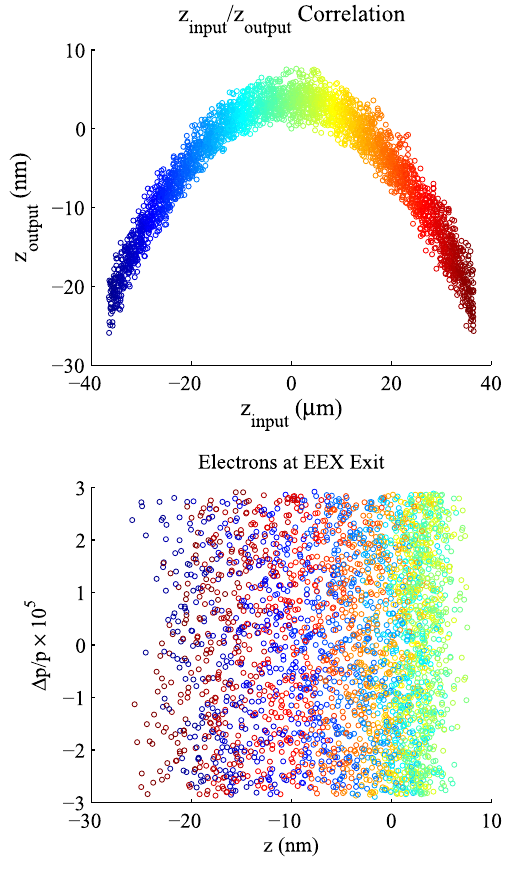
FIG. 5. (top) Correlation between the longitudinal position at the entrance to the transverse deflector cavity and at the exit of the EEX line. Particles are color coded to the input position. (bottom) Individual particles in the longitudinal phase space. The quadratic longitudinal coupling dominates the emittance growth of the electron